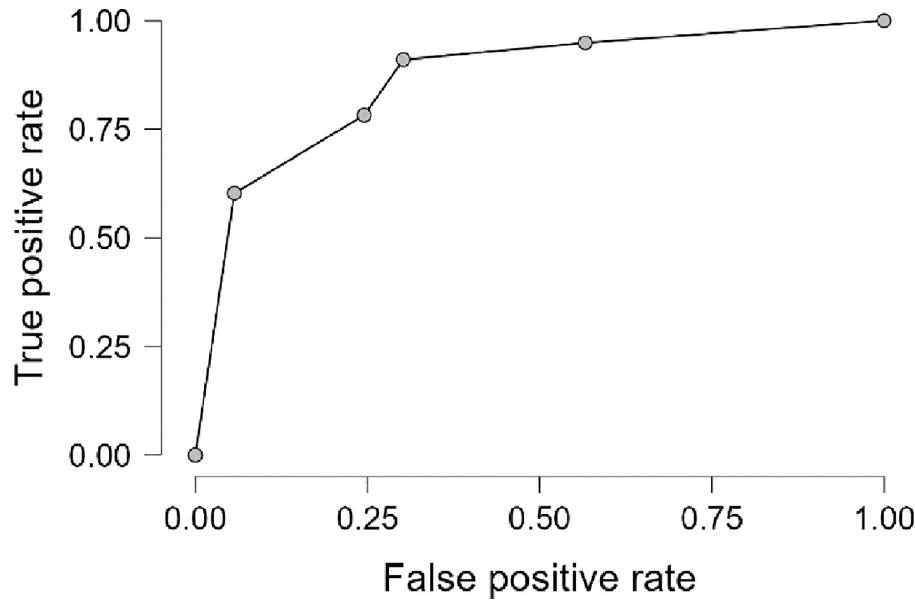
Fig 2. ROC curve of multivariate model of KTCN risk factors. ROC curve for the multivariate logistic regression analysis illustrating the performance of KTCN risk factors model. Model statistic values are presented in Table 5.